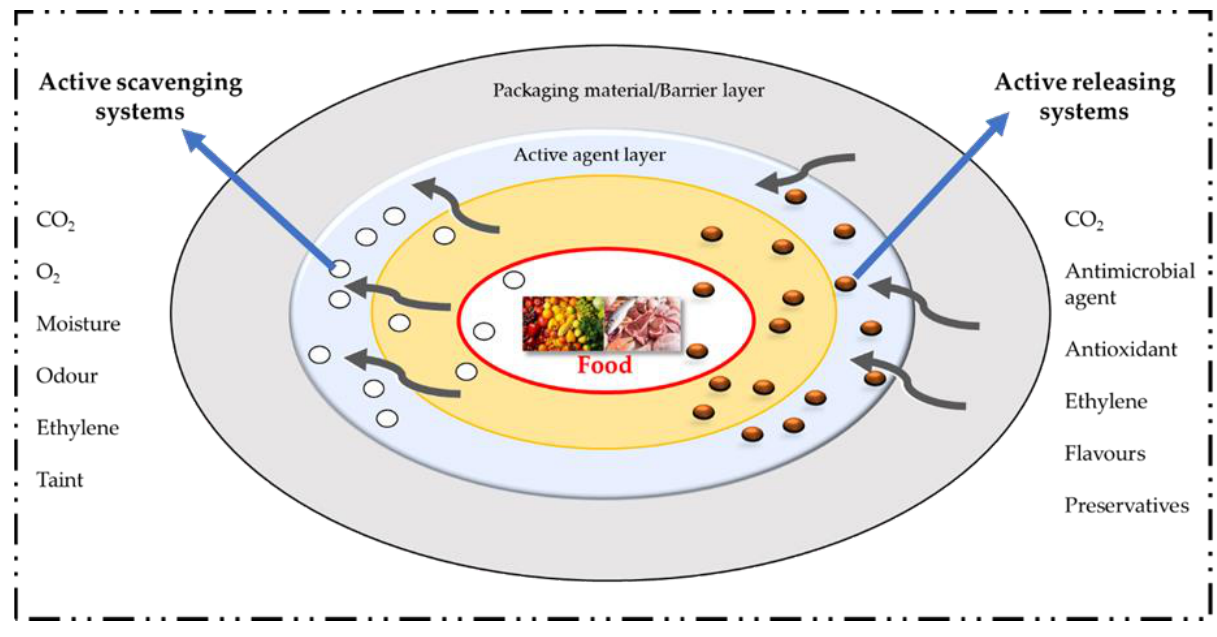
Figure 1. Illustration of the active scavenging and releasing systems used in food packaging.